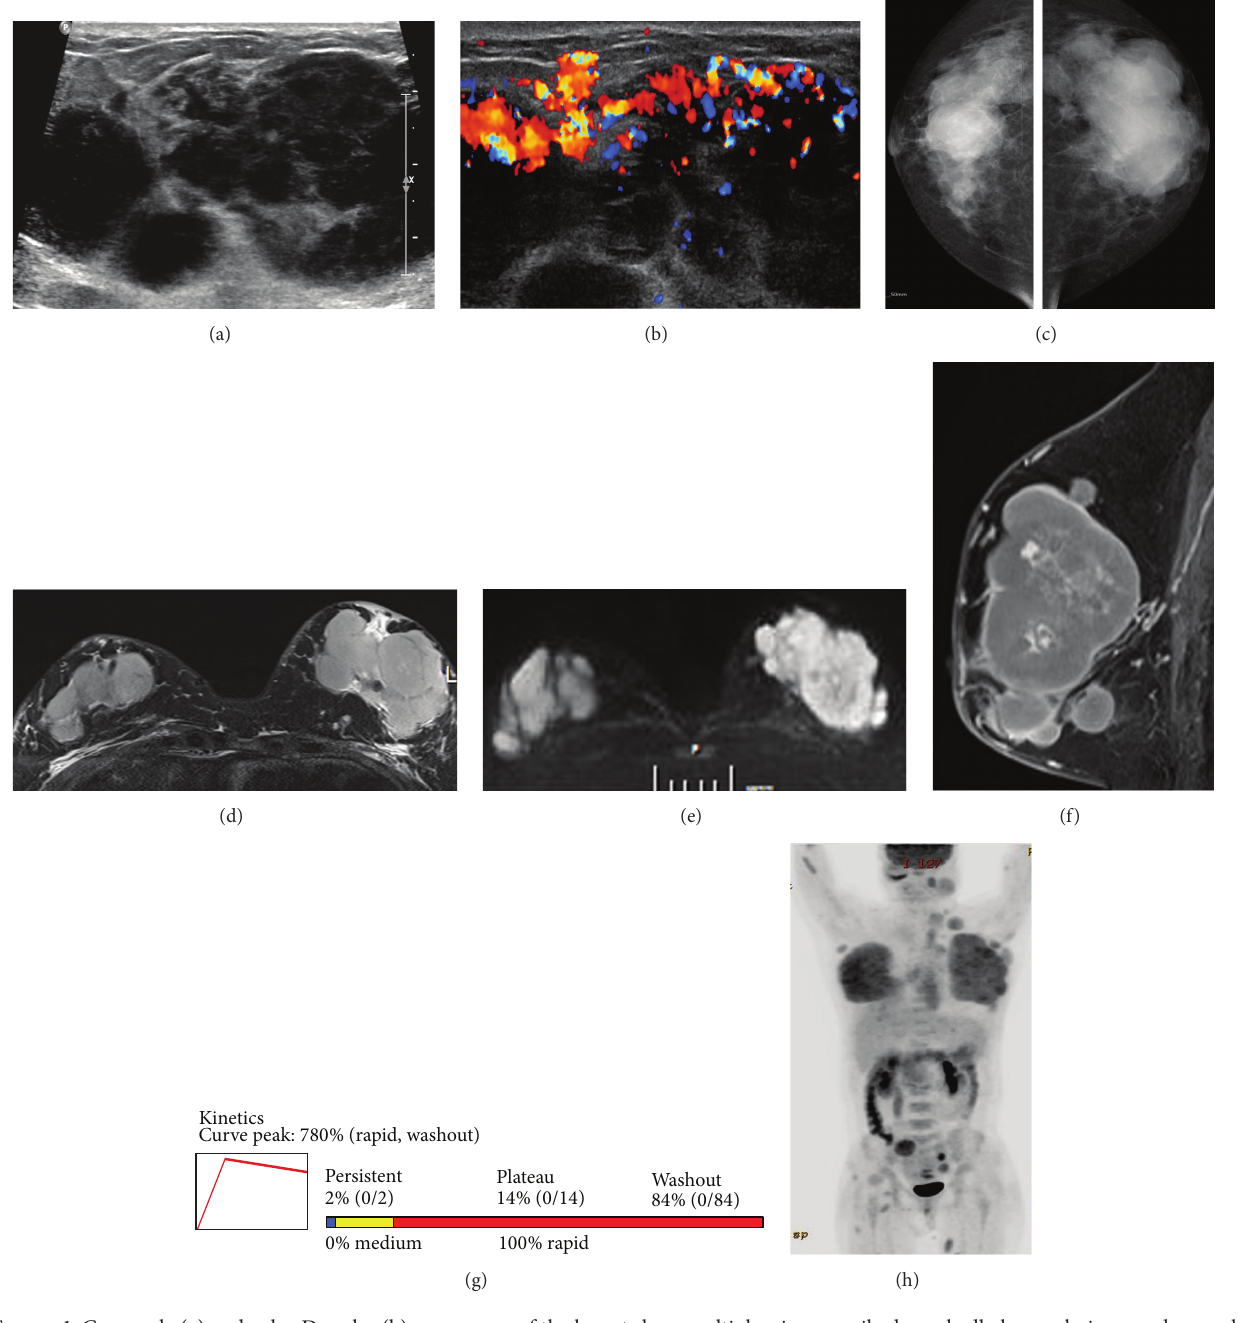
Figure 1: Gray scale (a) and color Doppler (b) sonograms of the breast show multiple, circumscribed, markedly hypoechoic, round or oval masses with highly increased vascularity. Mammograms (c) show circumscribed irregular conglomerated hyperdense masses invading both entire breasts. T2-weighted image of breast magnetic resonance imaging (MRI) (d) shows multiple, circumscribed, oval or round masses of high signal intensity (SI) in both breasts. The masses reveal high SI on diffusion-weighted image (e) with a low apparent diffuse coefficient value (not shown) suspicious for malignancy. Early phase of dynamic contrast-enhanced sagittal T1-weighted MRI (f) shows multiple circumscribed masses with strong homogeneous enhancement. Time-intensity curve of dynamic contrast-enhanced MRI (g) shows early strong (780% of the baseline value) and fast/delayed washout enhancement kinetics, suggestive of malignancy. Follow-up positron emission tomography-computed tomography scan (h) reveals massive breast plasmacytomas (SUVmax 6.3), invading both entire breasts. Metastatic lymphadenopathies throughout the whole body and metastatic masses in the abdomen, left cheek, both shoulders, chest wall, right buttock, and both thighs are